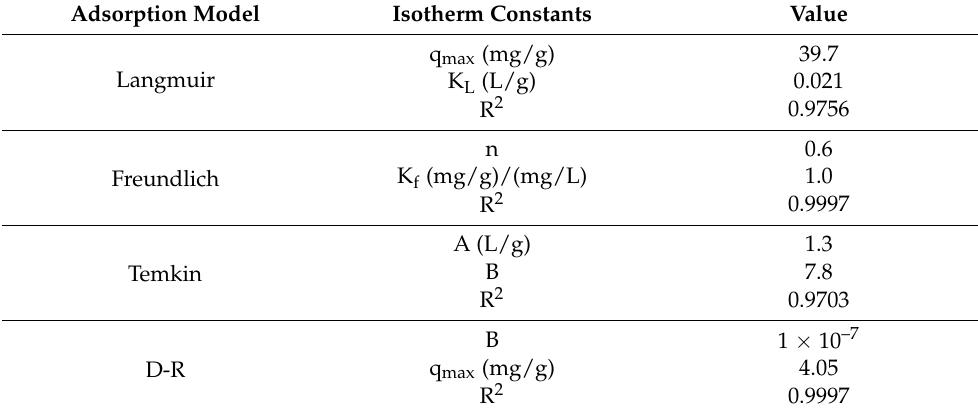
Table 3. Adsorption isotherm constants obtained from the four adsorption isotherm models.